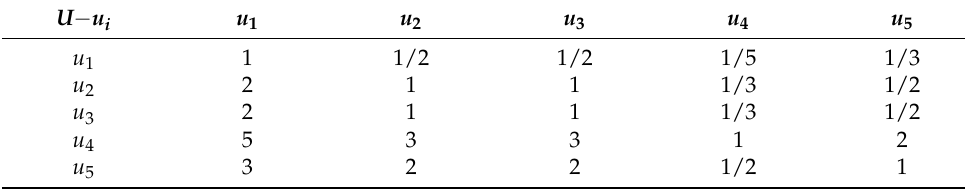
Table 2. Judgment matrix of U − u i .